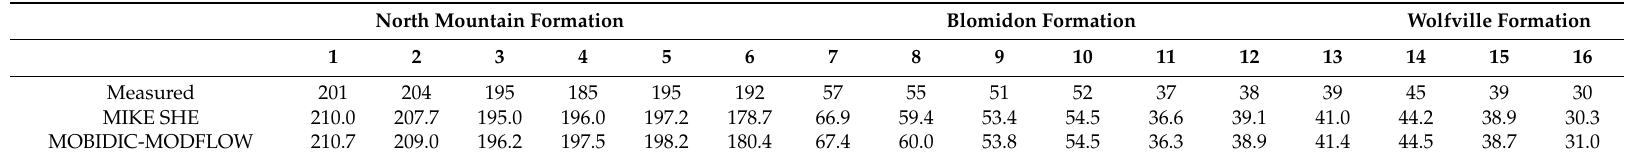
Table 3. Measured and simulated groundwater heads (in meters) at the groundwater wells shown in Figure